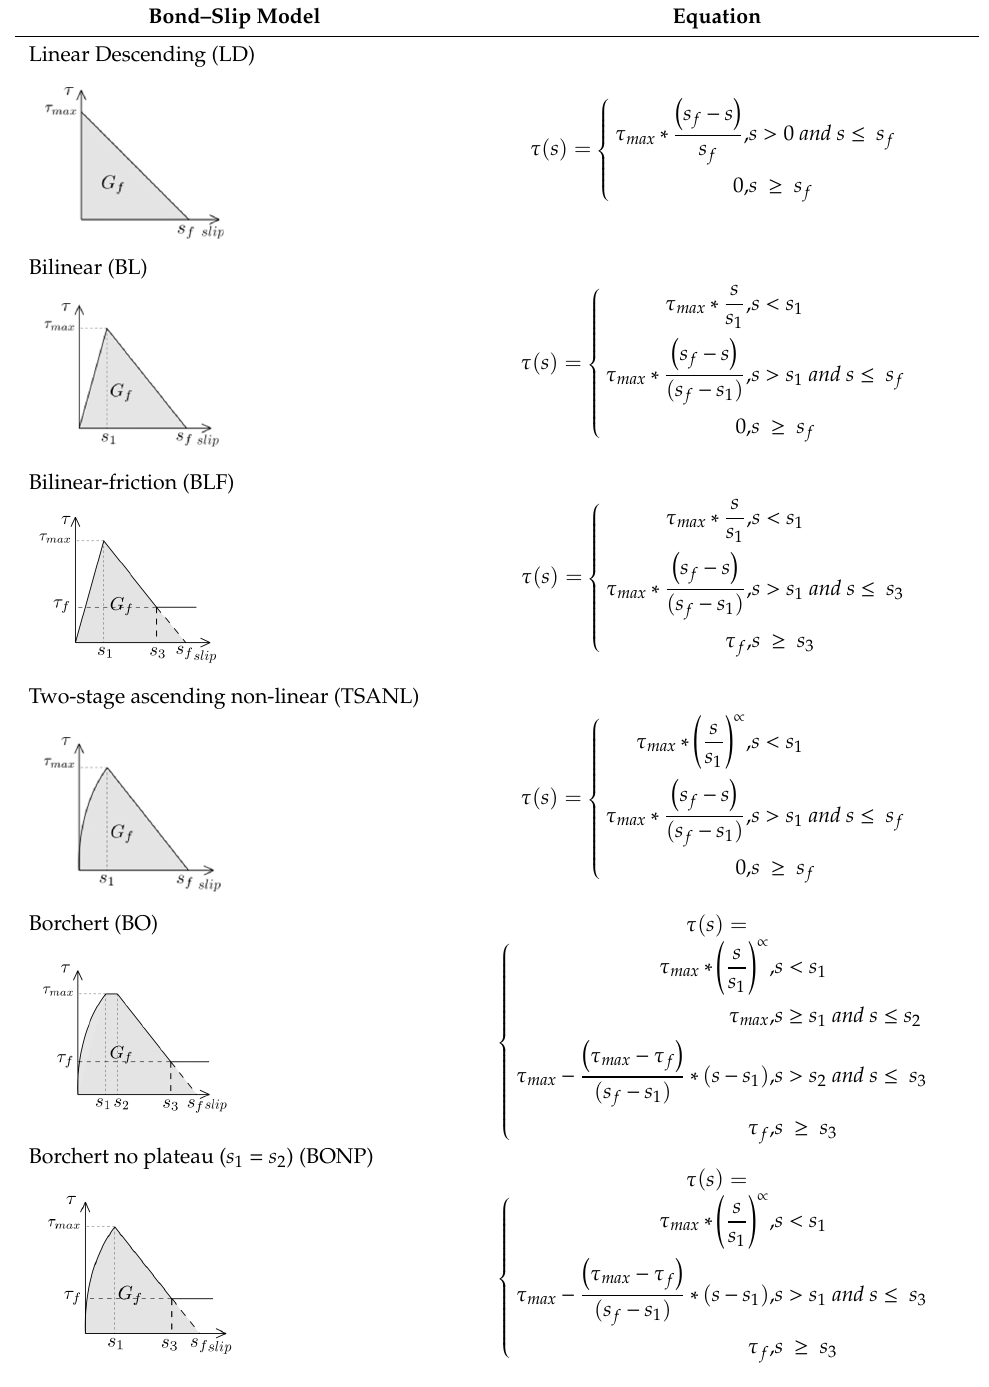
Table 1. Equations of the bond–slip models used in the parametric study.